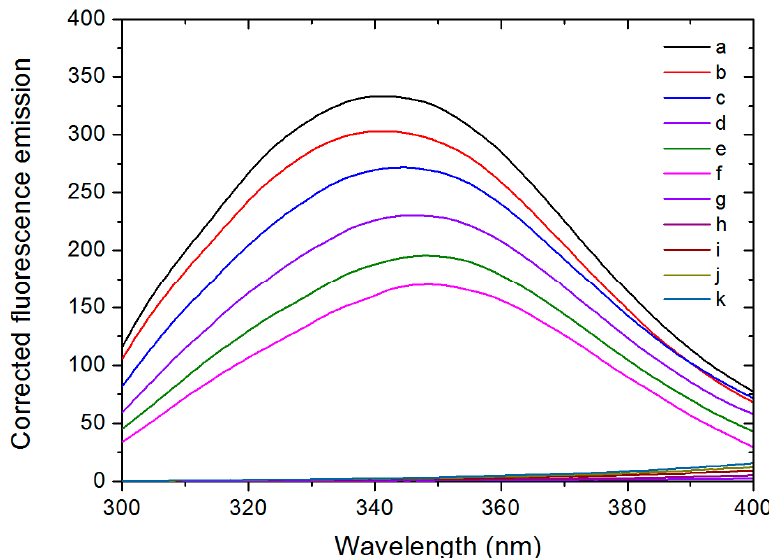
Figure 6. Corrected fluorescence emission spectra of HSA without (a) and with various AGuIX ® concentrations, AGuIX ® :HSA ratios from 5:1 to 45:1 (b–f) and AGuIX ® alone at corresponding concentration (g–k) in 67 mM phosphate bu ff er at pH 7.4, 25 ◦ C and upon excitation at 280 nm.